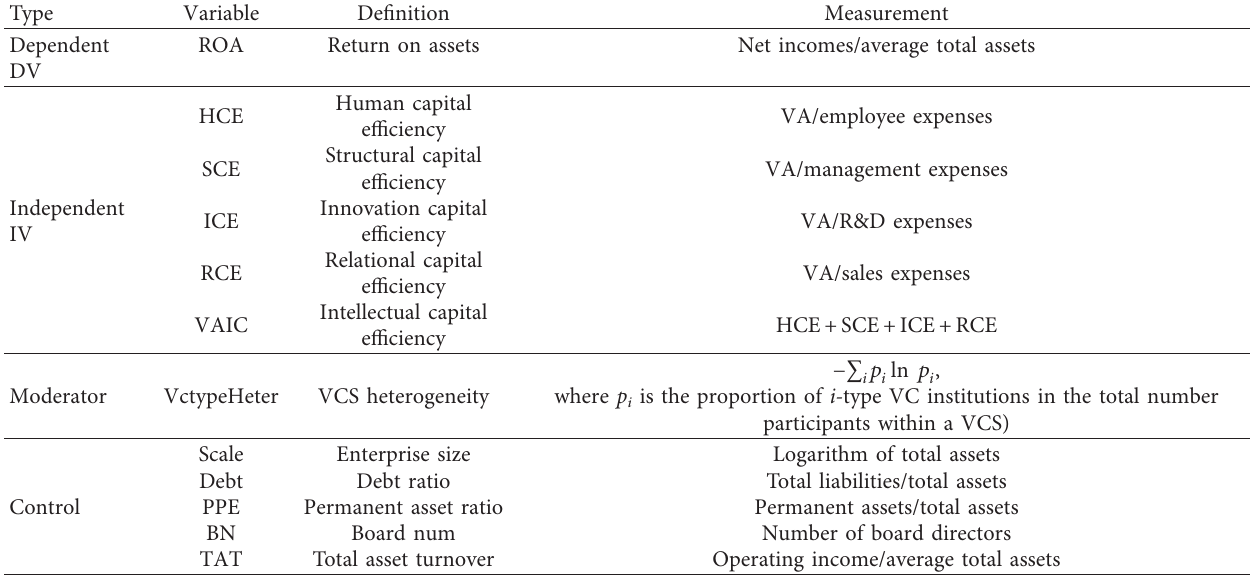
Table 2: Variable definitions and